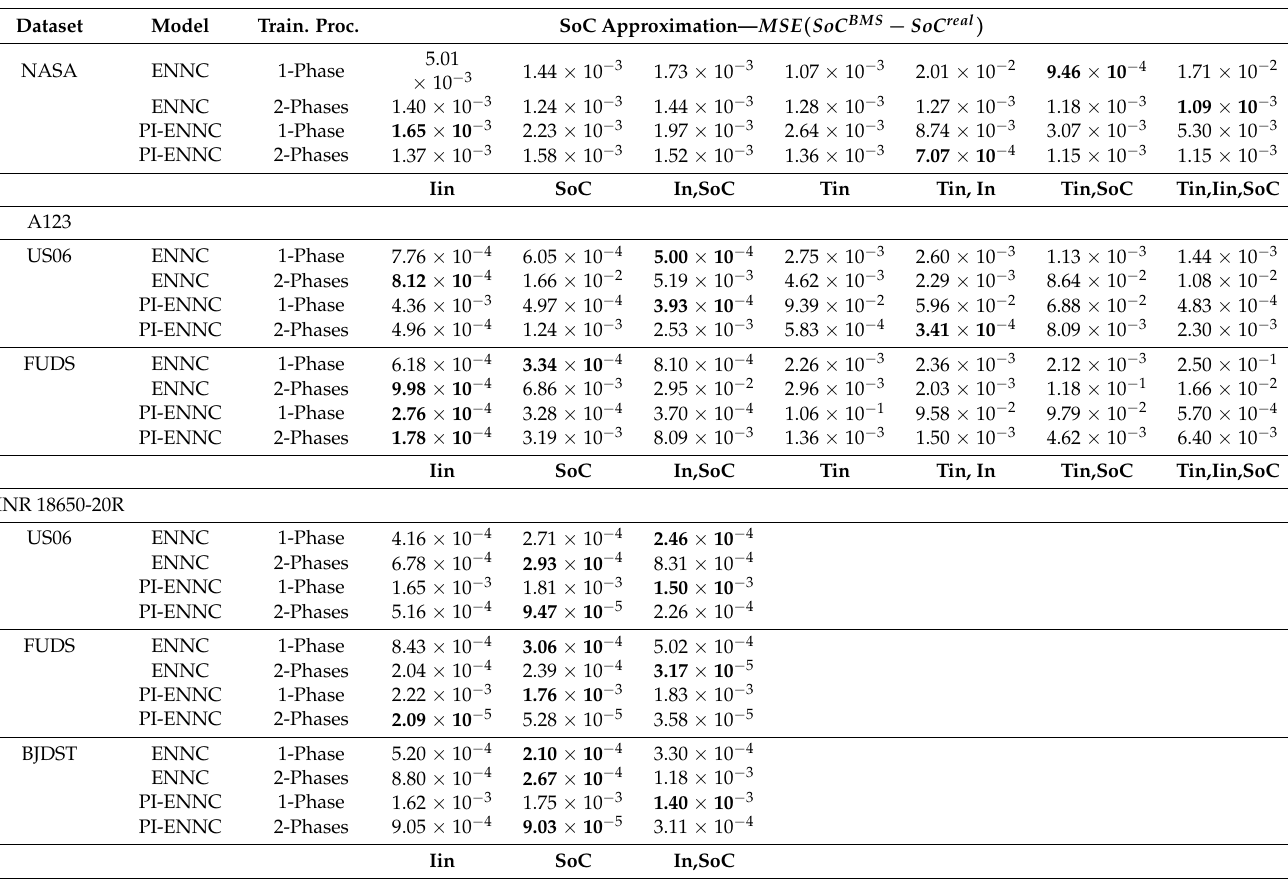
Table 4. Test results on SoC MSE sorted per dataset, BMS model, training procedure and input tuple definition. Dataset